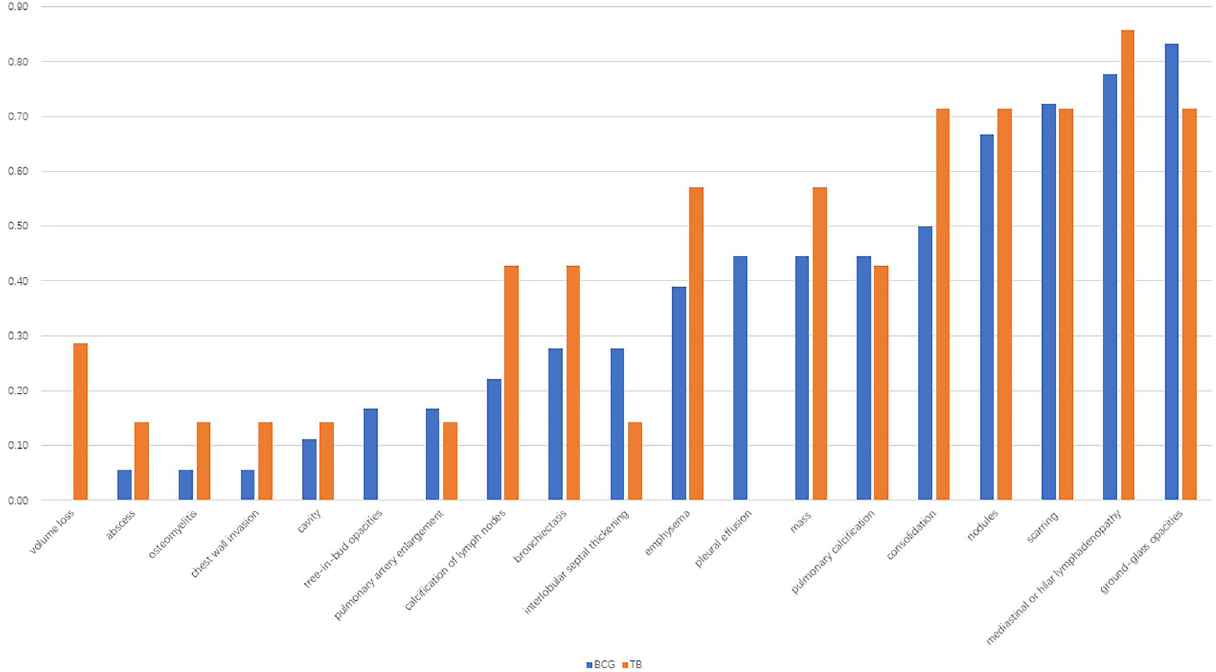
Figure 4. Percentage of thoracic lesions in patients with BCG and TB infections.